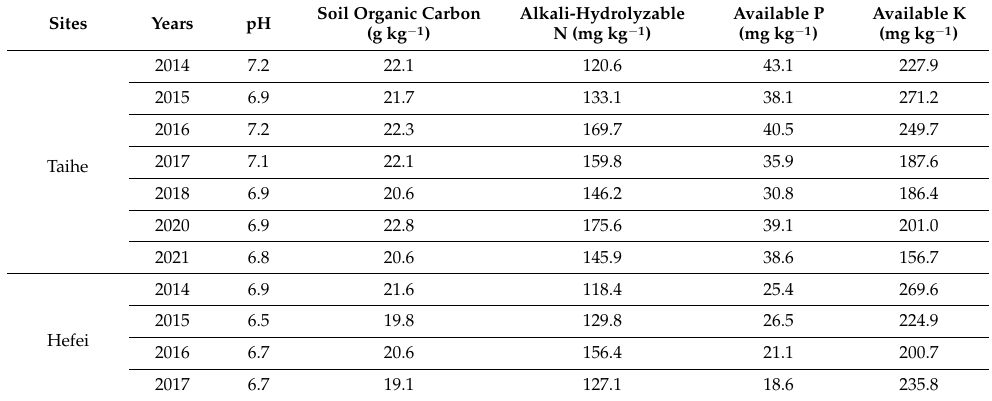
Table 1. The physical and chemical characteristics of the topsoil during the experiment at Taihe and Hefei.